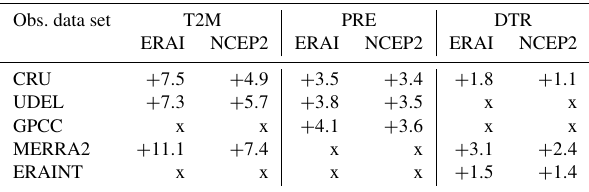
Table 4. Changes of the SS calculated for experiment q with re- spect to reference simulation a, when both simulations are driven by ERA-Interim (left) and NCEP2 (right) reanalysis